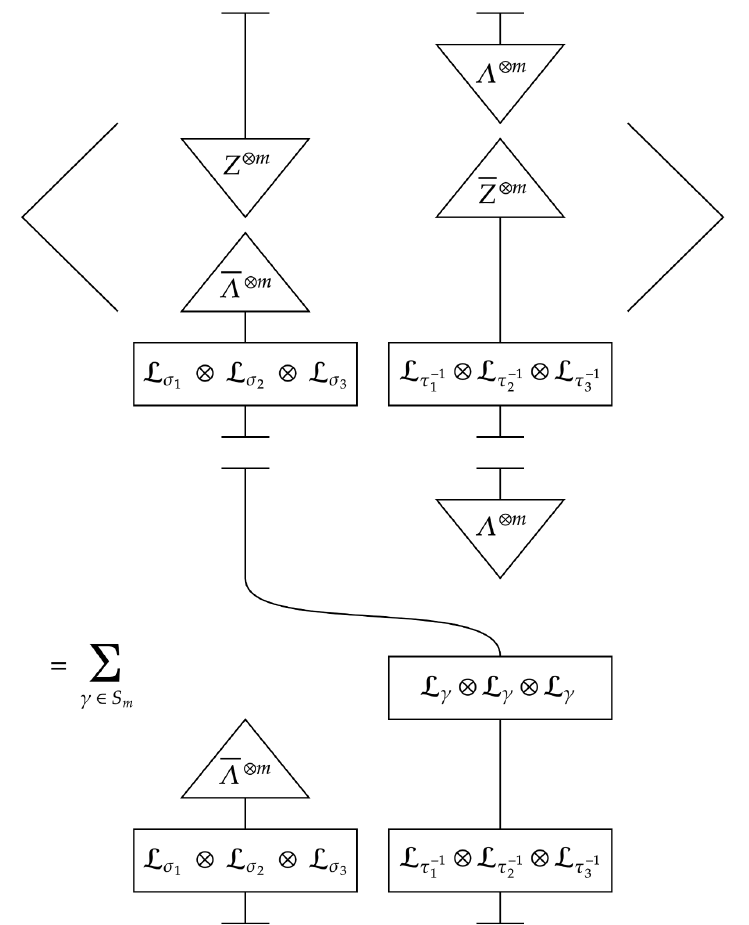
Figure 7 . The diagrammatic representation of the tensor model two-point function of gauge invariant operators with classical tensor witnesses. This example takes Λ and Z as contravariant tensors and their conjugates as covariant tensors, where all fields are rank-3 and displayed using triangles. The figure implies (via their associated linear operators) that each of the three indices on every term in the tensor product, is permuted by σ 1 , σ 2 and σ 3 (or τ − 1